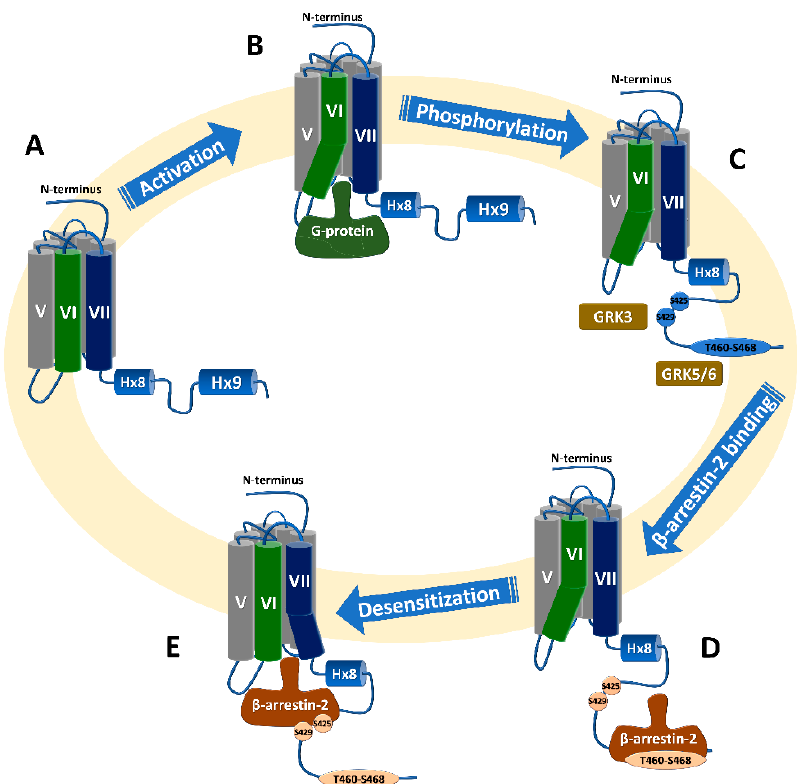
Figure 3. Canonical CB1 receptor signaling and β -arrestin2 interaction with the receptor. ( A ) Inactive state of the receptor with closed IC domain. ( B ) Agonist binding activates the receptor with opening at IC domain, mainly due to the TMH6 conformational change followed by G-protein coupling. ( C ) Phosphorylation of proximal (S425, S429) and distal (possibly at T460–S468) phosphorylation sites, by GRK3 and GRKs5 / 6, respectively. ( D ) β -arrestin2 binding to the C-terminus starts with an interaction with the distal phosphorylated C-terminus, which can mediate receptor internalization; followed by ( E ) possible conformational change at the IC domain of the receptor and the arrestin interacts with the proximal phosphorylated C-terminus, resulting in receptor desensitization.